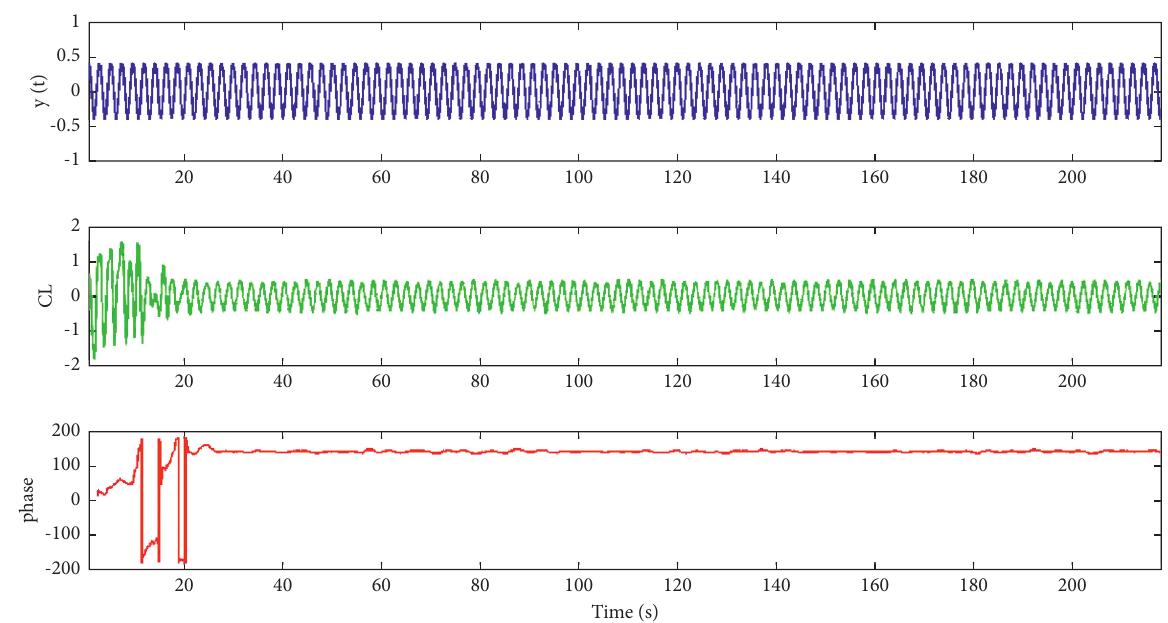
Figure 4: The cylinder motions, lift coefficient, and phase angle in time-domain at A ∗ � 0 . 4, λ ∗ � 6 . 2.